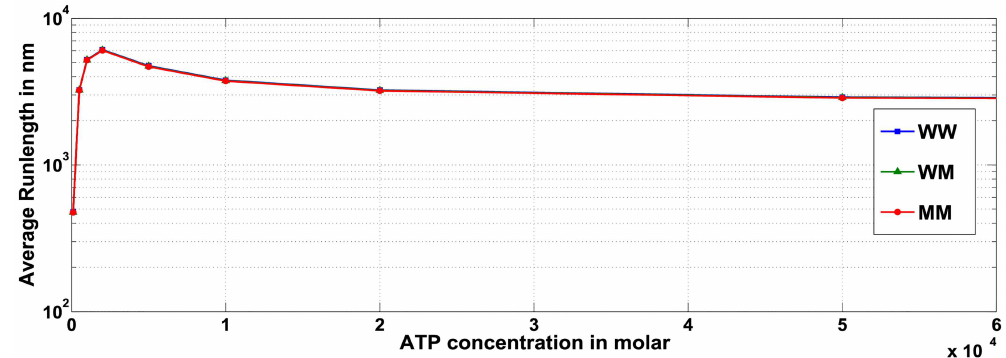
Fig 13. Effect of ATP concentration on run-length for ensembles WW, WM and MM against load force of 0.2 pN .